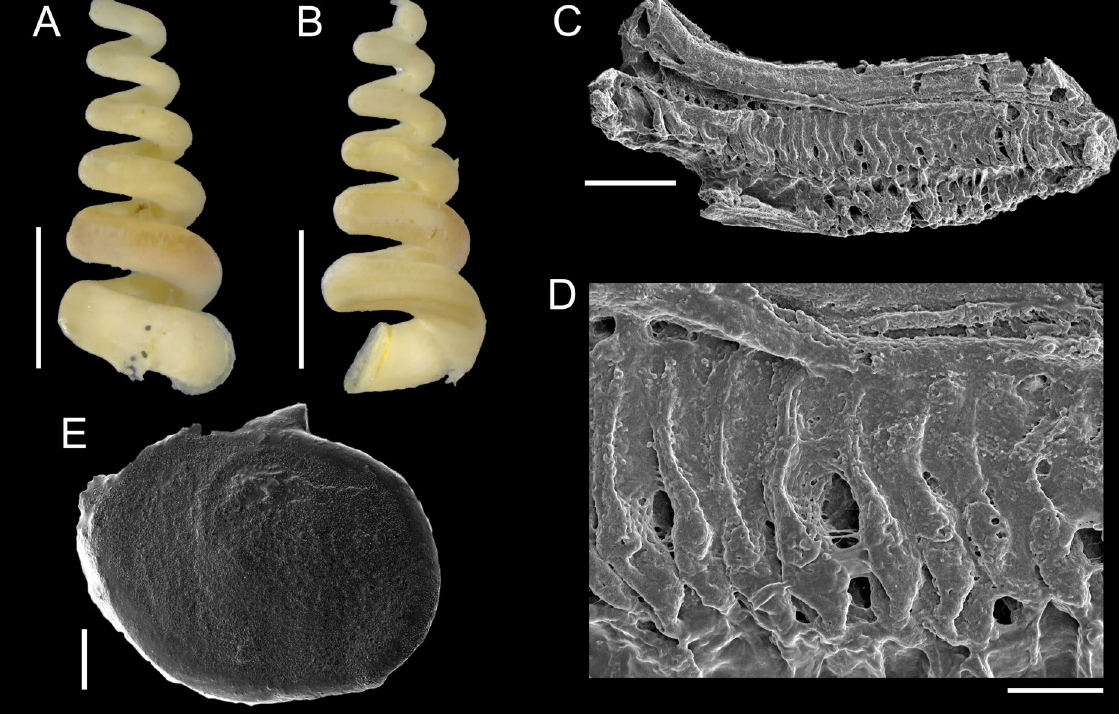
Fig. 9. Iniforis pseudothomae Rolán & Fernández-Garcés, 1993. A–B, E . MNRJ 32881. C–D . MZSP 100957. A–B . External morphology. C–D . Ctenidium. E . Operculum. Scale bars: A–B = 1 mm; C = 200 µm; D = 50 µm; E = 100